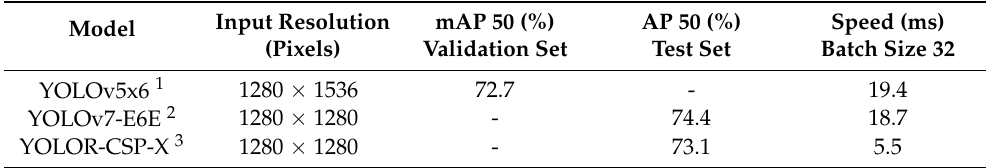
Table 5. YOLO versions pre-trained checkpoints performance on large-scale public object detec- tion